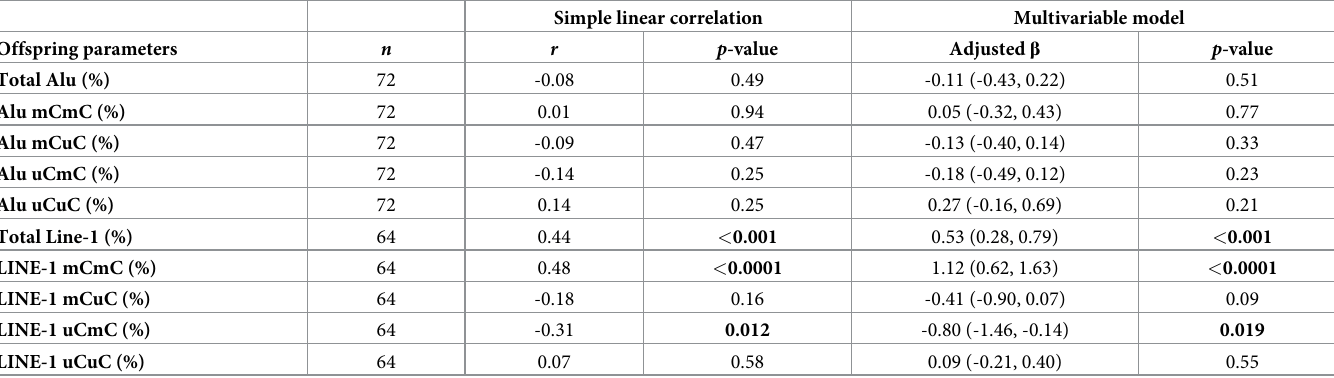
Table 4. Associations between maternal plasma zinc concentrations in late pregnancy and DNA methylation levels in the young adult offspring.